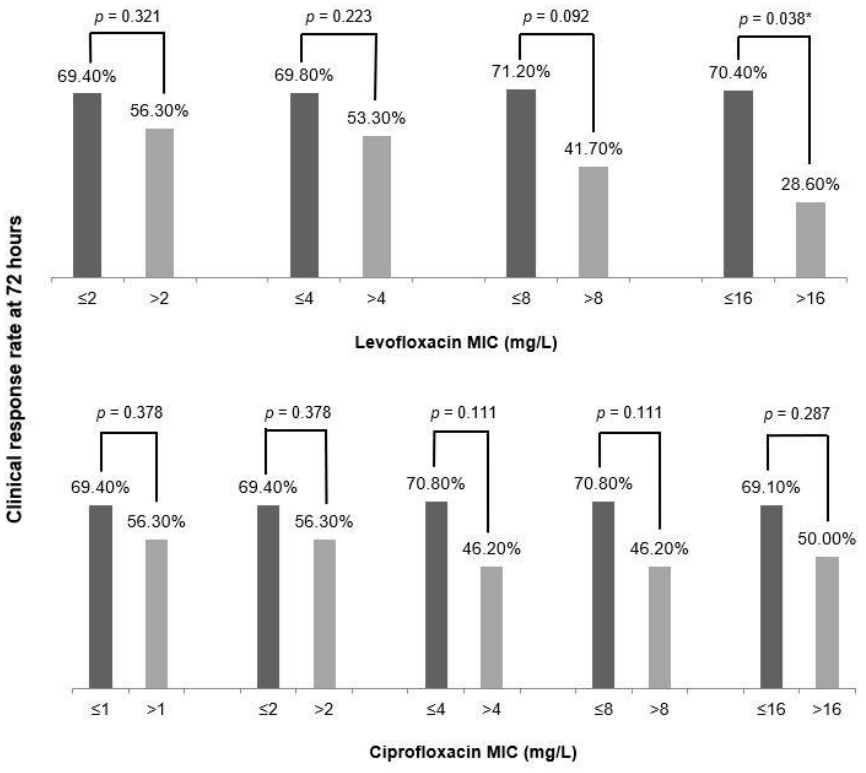
Figure 1. Correlation between minimal inhibitory concentrations (MICs) of levofloxacin and ciprofloxacin and clinical response rates at 72 h after the inception of empirical fluoroquinolone treatment in patients with acute pyelonephritis . * p < 0.05.